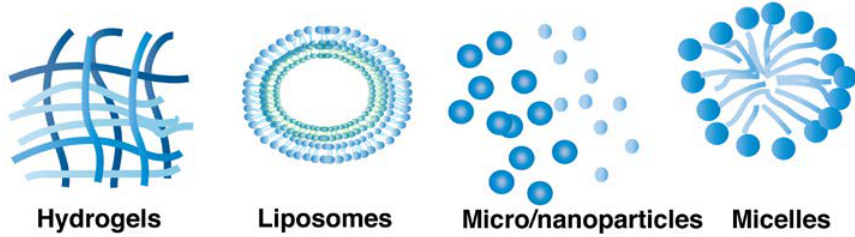
Figure 4. Common formulation strategies used to prolong protein release.